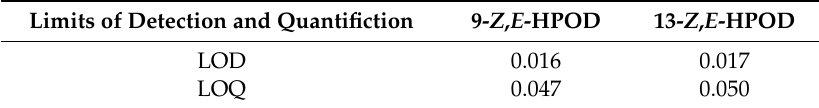
Table 5. Limits of detection (LOD) and quatification (LOQ) for 9- Z , E -HPODE and 13- Z , E -HPODE. Limits of Detection and